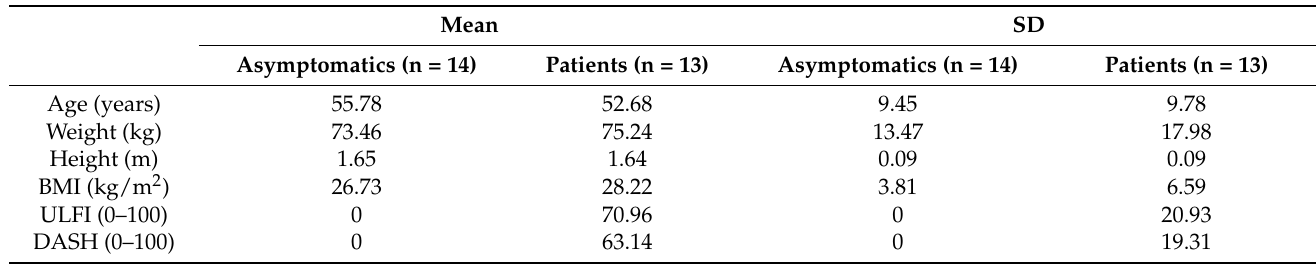
Table A2. Descriptive and anthropometric variables and questionnaires’ punctuation (mean, SD) in both